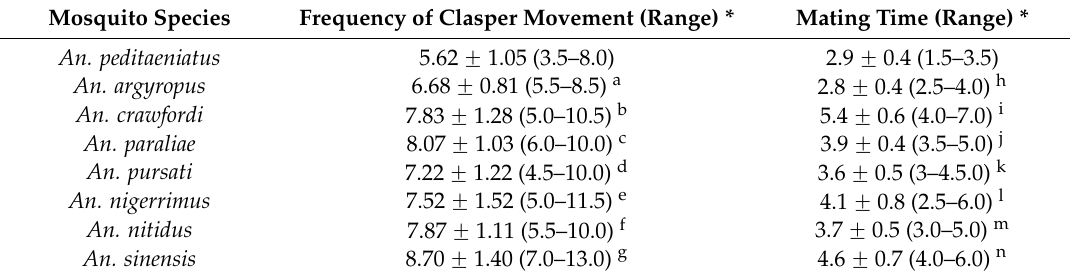
Table 7. Comparative measurements of mating time (duration in seconds) and frequency of clasper movement per copulation in the eight species of the Hyrcanus Group ( n =